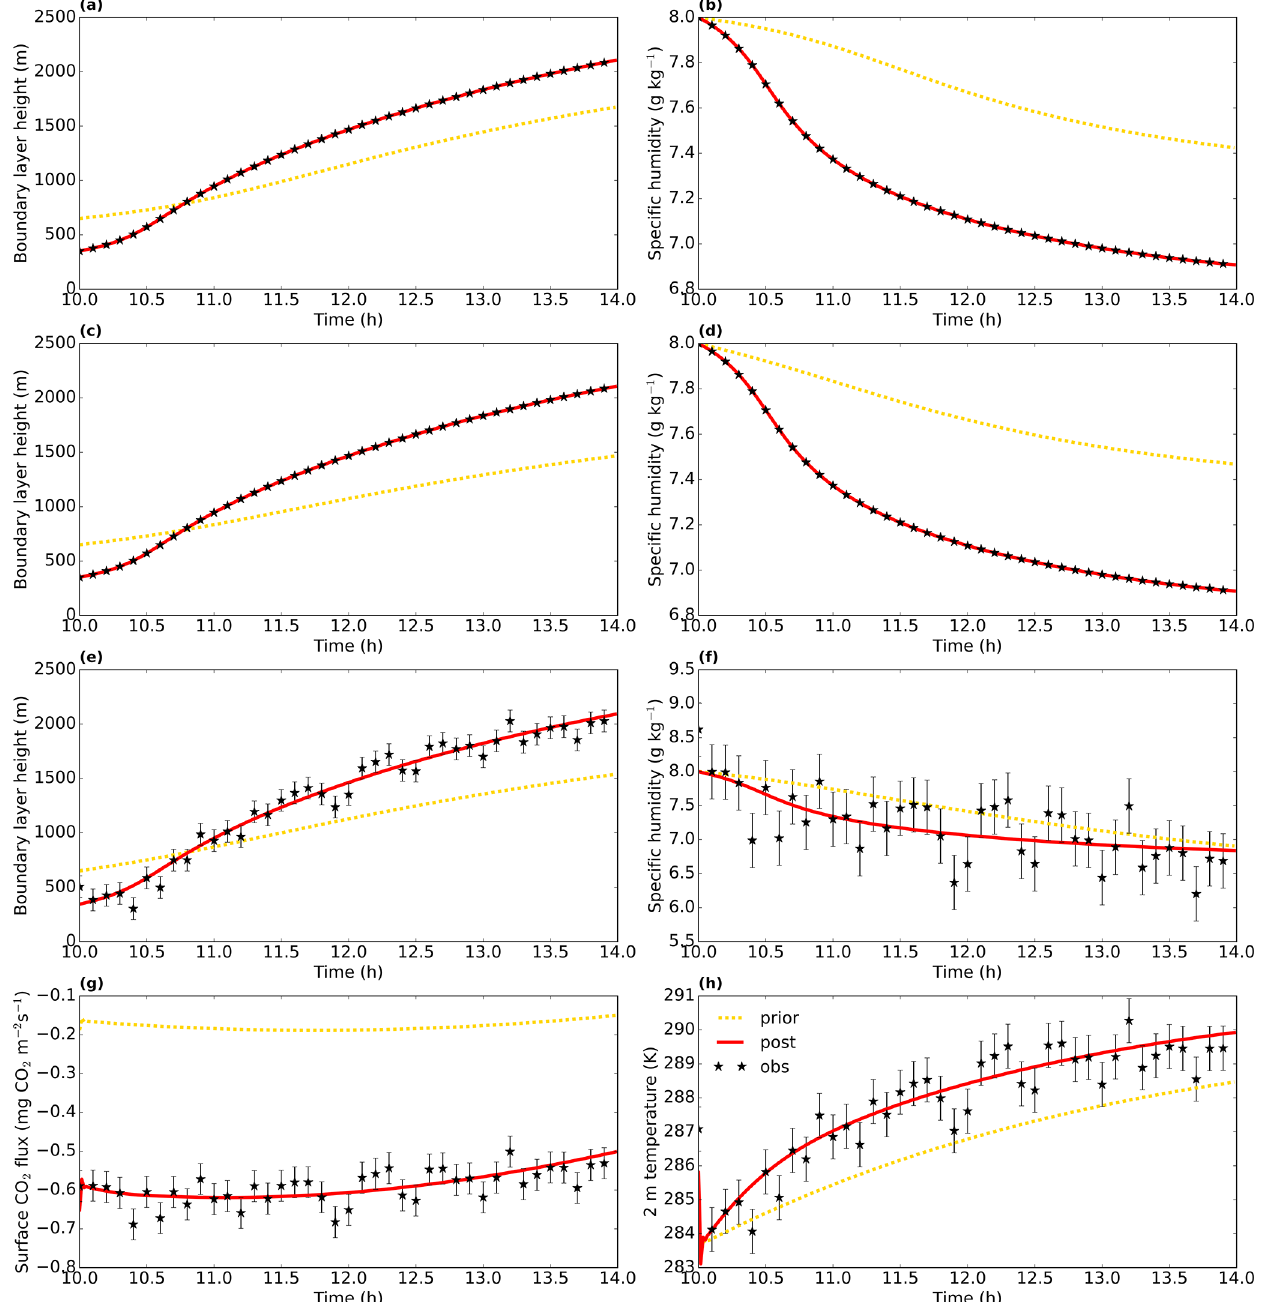
Figure 3. Model output from three observation system simulation experiments from Sect. 8.1, namely the two-parameter-state experiment with albedo and the initial boundary layer height (top row), the five-parameter-state experiment with two observation streams (second row), and the experiment with perturbed observations (third and fourth rows). The term “post” means posterior, i.e. the optimised simulation. Even though the posterior lines look very similar for the first and second rows, the model parameters are not identical. The specific humidity is from the mixed layer. The error bars show the observational error standard deviations σ O , which are here equal to σ I